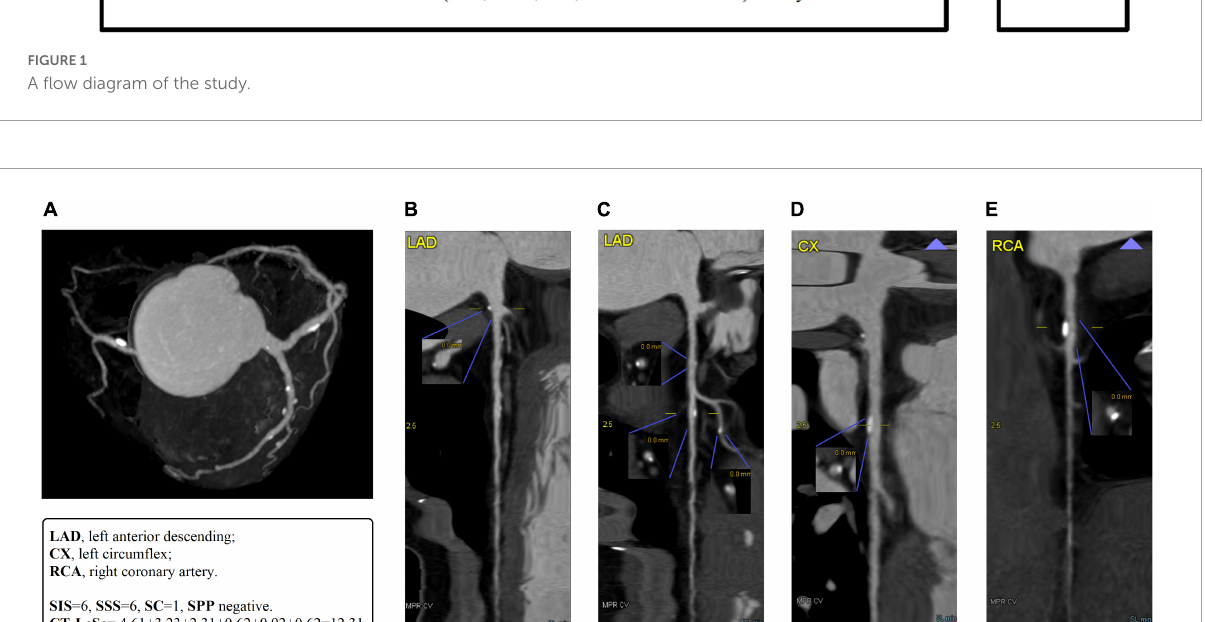
FIGURE2 A case example of 55-years-old man with T2DM for 10 years. (A) The MIP of coronary tree with blood pool removal shows right dominance and six non-obstructive stenosis segments in LAD, D1, LCx, and RCA. (B) The straightened MPR of LAD shows a mixed plaque with mild lumen stenosis in LM. The CT-LeSc = 5 × 1.5 × 0.615 (weighting for localization × type of plaque × stenosis severity) = 4.61. (C) The straightened MPR of LAD shows mixed plaques with mild lumen stenosis in proximal and mid LAD, a calcified plaque with mild lumen stenosis in D1. The CT-LeSc = 3.23 (3.5 × 1.5 × 0.615), 2.31 (2.5 × 1.5 × 0.615), 0.62 (1 × 1 × 0.615), respectively. (D) The straightened MPR of LCx show a calcified plaque with mild lumen stenosis in proximal LCx. The CT-LeSc = 0.92 (1.5 × 1 × 0.615). (E) The straightened MPR of RCA show a calcified plaque with mild lumen stenosis in proximal RCA. The CT-LeSc = 0.62 (1 × 1 × 0.615). The total CT-LeSc of this patient = 4.61 + 3.23 + 2.31 + 0.62 + 0.92 + 0.62 = 12.31. There are six segment coronary plaques, so the SIS of this patient is 6. Mild lumen stenosis is found in all 6 plaques with score 1 of SSS, the SSS of this patient is 6. The SC = SSS ÷ SIS = 1. There is no severe proximal plaque in the proximal of LAD, LCx, and RCA, so the SPP is negative. MIP, maximum density projection; MPR, multiplanar reconstruction; LAD, left anterior descending; LM, left main; D1, 1st diagonal; LCx, left circumflex; RCA, right coronary artery; CT-LeSc, CCTA-adapted Leaman score; SIS, segment involvement score; SSS, segment stenosis score; SC, stenosis coefficient; SPP, severe proximal